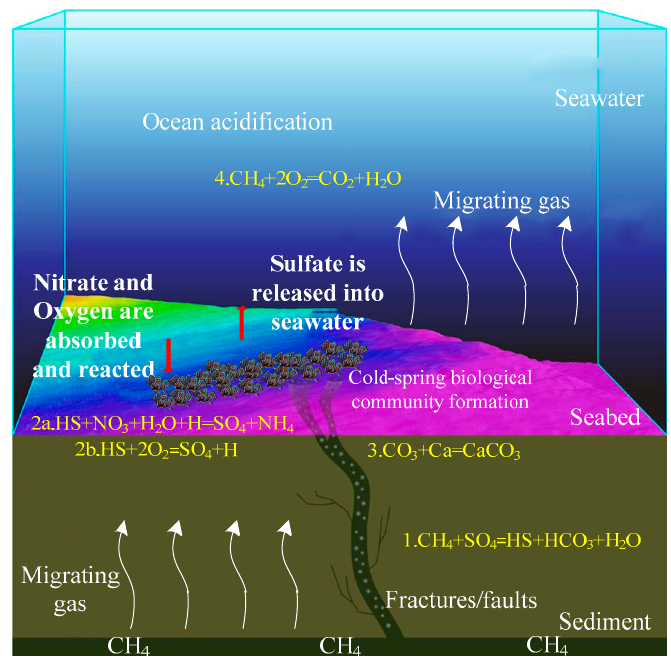
Figure 7. Chemical reaction after MGH decomposition [39].